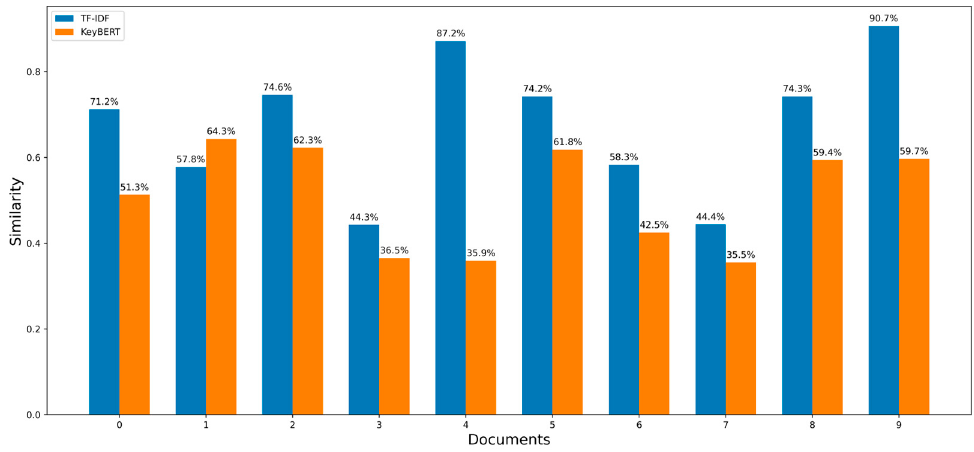
Figure 7. Comparison of the similarity of each document with author-assigned keywords in differ- ent approaches.